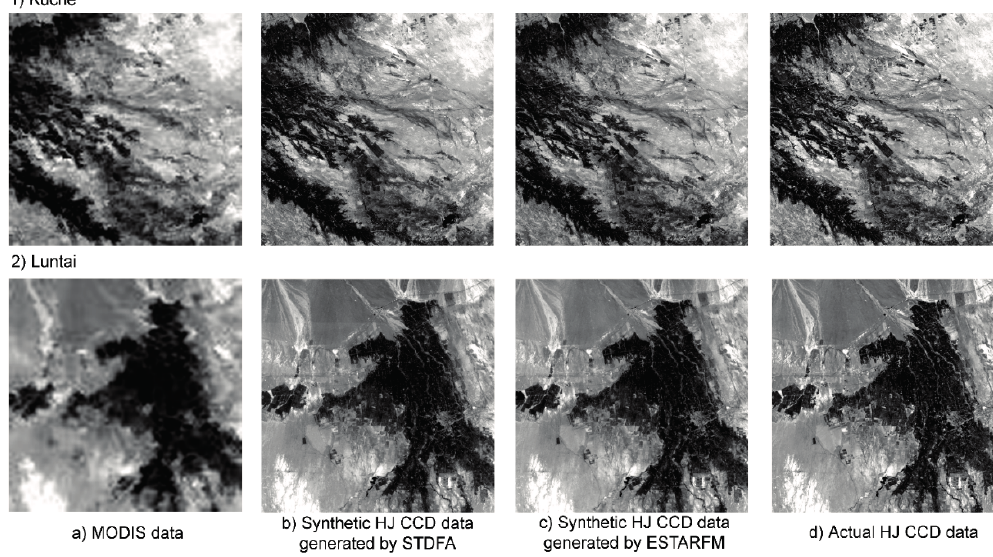
Figure 2. Comparison of MODIS, HJ CCD and synthetic data generated by the ESTARFM and STDFA acquired on 7 October 2013: ( a ) MODIS data; ( b ) synthetic HJ CCD data generated by STDFA; ( c ) synthetic HJ CCD data generated by ESTARFM; ( d ) actual HJ CCD